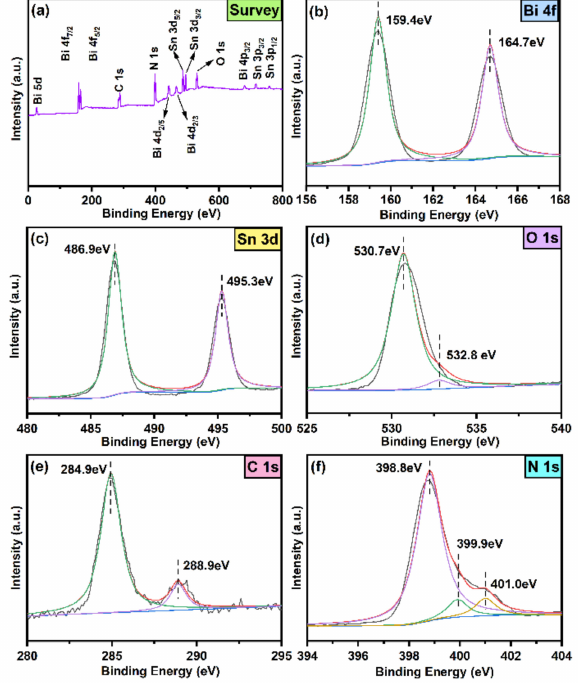
Figure 3. XPS survey pattern of BSCN ( a ); the high-resolution XPS spectra of Bi 4f ( b ), Sn 3d ( c ), O 1s ( d ), C 1s ( e ), and N 1s ( f ).